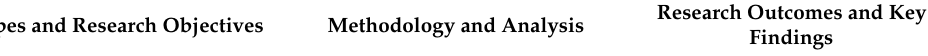
Table 9. The context of buildings—Group 2 (studies are presented in reverse chronological order and in last name of first author alphabetical